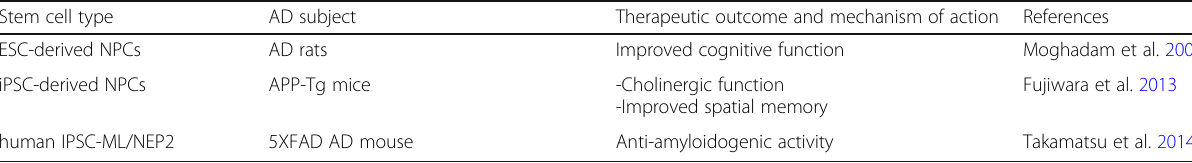
Table 1 Transplantation studies of stem cells in AD animal models